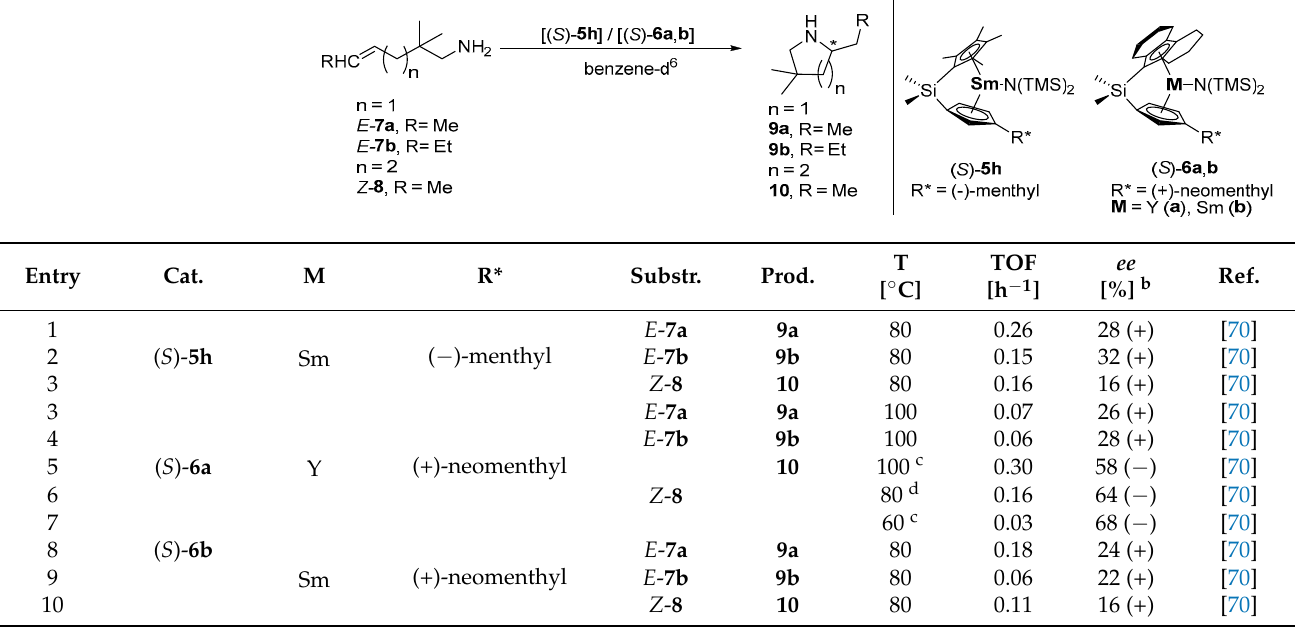
Table 2. Catalytic asymmetric hydroamination of E - 7a , b and Z - 8 using chiral rare earth metal complexes ( S )- 5h and ( S )- 6a , b a .